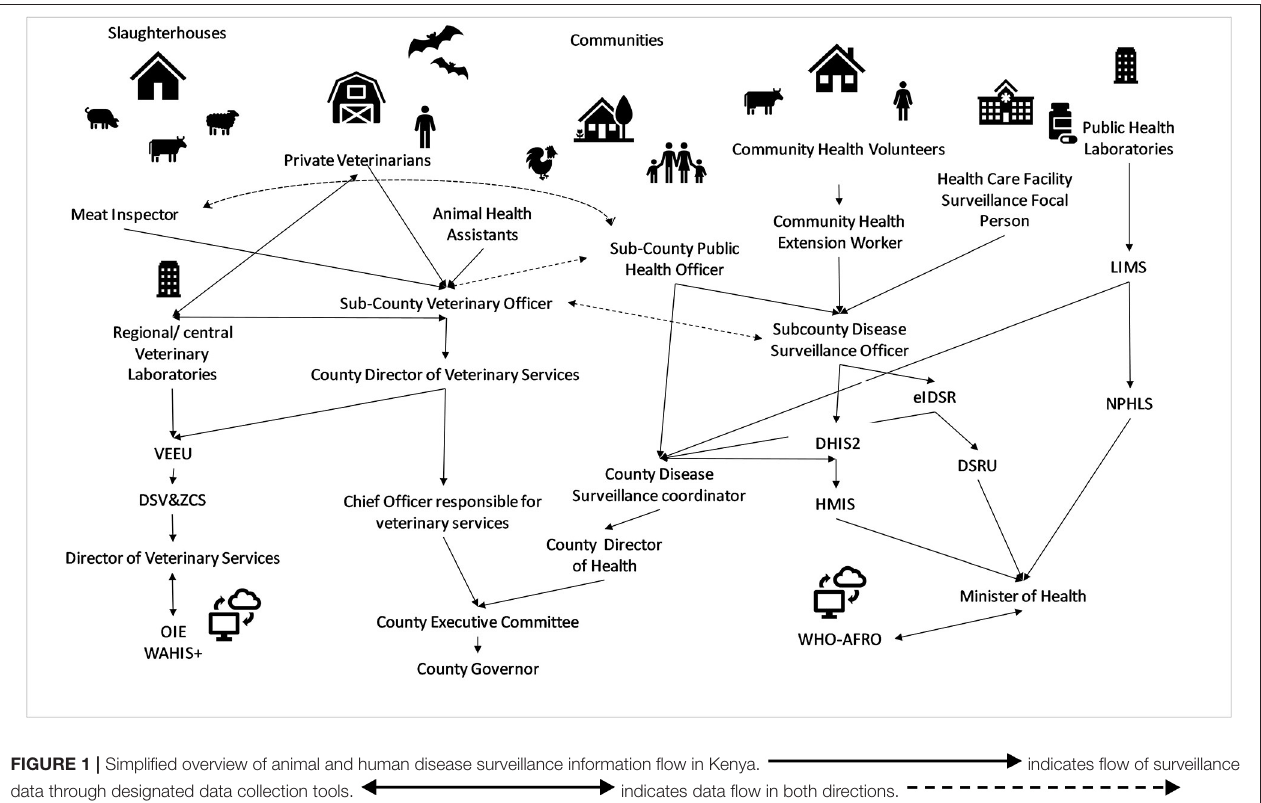
FIGURE 1 | Simplified overview of animal and human disease surveillance information flow in Kenya. indicates flow of surveillance data through designated data collection